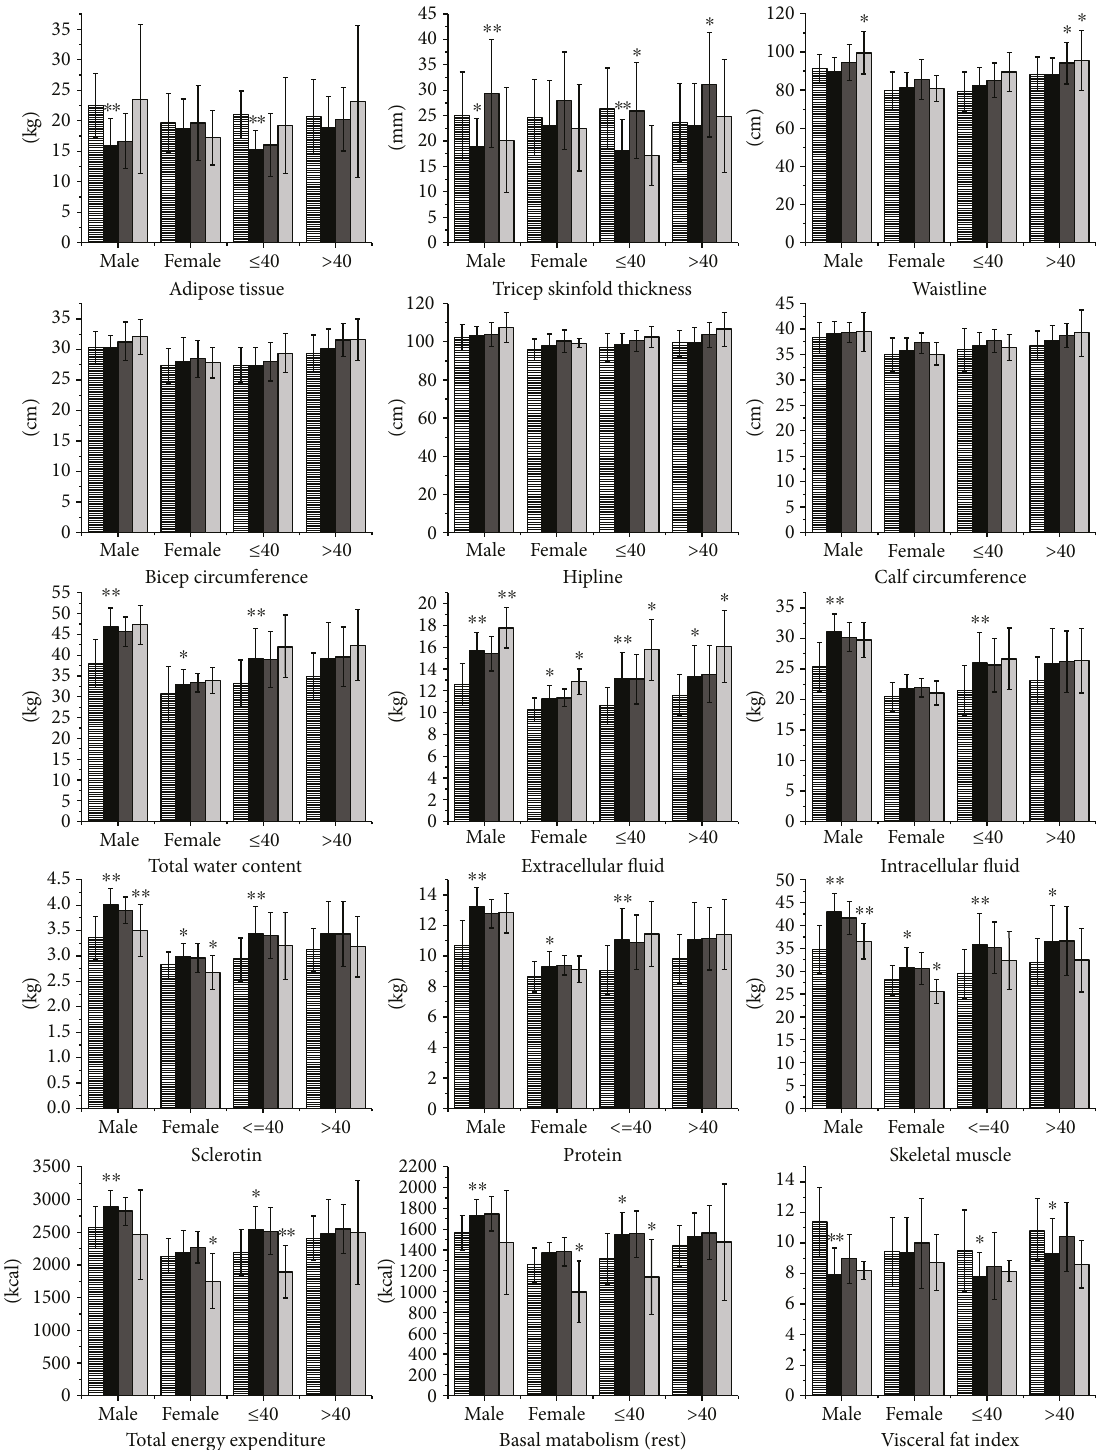
Figure 1: Preoperative characteristics and postoperative changes in body composition and metabolism in patients with acromegaly. This fi gure includes 15 indices of body composition and metabolism in acromegaly patients and the controls. The bars with transverse lines represent the values of the controls. The black bars represent indices of the patients with untreated acromegaly. Dark gray and light gray bars represent indices of the patients with acromegaly at 3 months after surgery and 1 year after surgery, respectively. The ∗ above the black bars represents the preoperative comparison of results between the acromegaly patients and the controls. The ∗ above the dark gray and light gray bars represents the comparison of results between indices of the acromegaly patients during the postoperative and preoperative periods. ∗ p < 0 05 ; ∗∗ p < 0 01